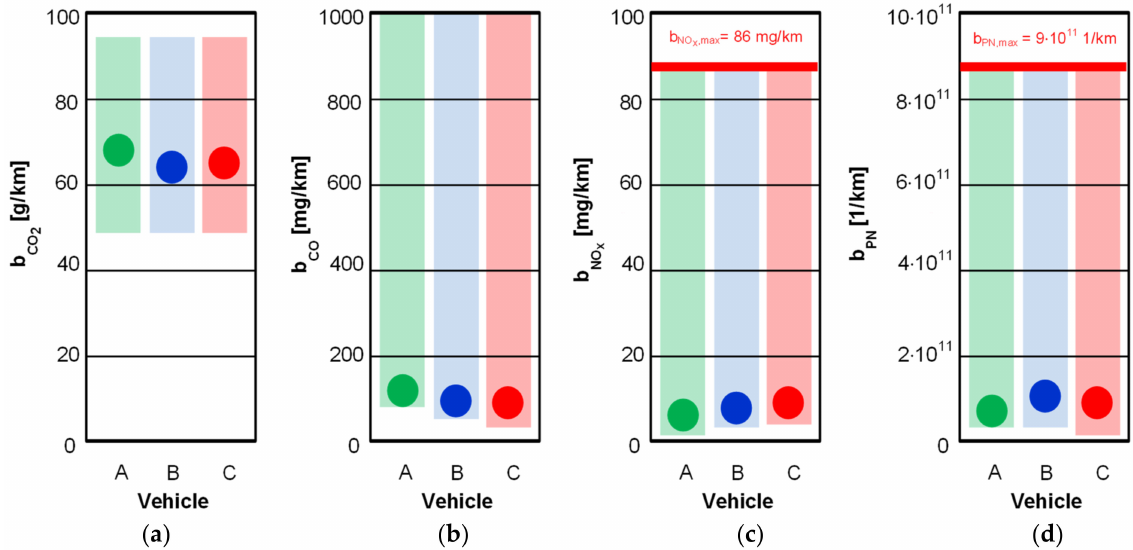
Figure 8. Values of the minimum road emission intensity of carbon dioxide ( a ), carbon monoxide ( b ), nitrogen oxides ( c ), and particle number ( d ) in the RDE test obtained according to the algorithm for a constant emission intensity; data provided in Tables